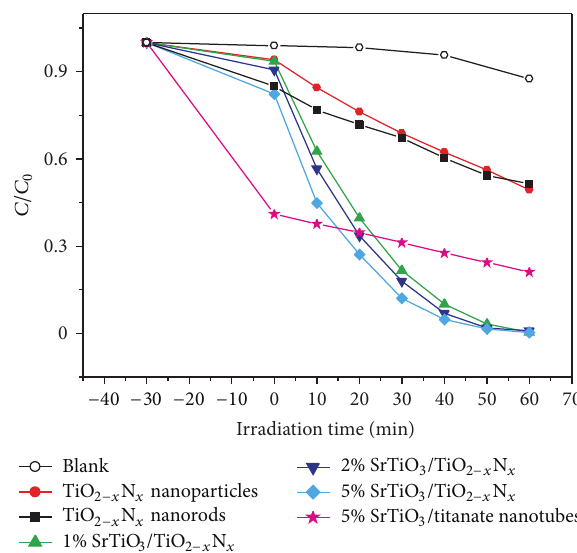
Figure 5: Photodegradation of MB under light irradiation without any photocatalyst (blank) and over the prepared